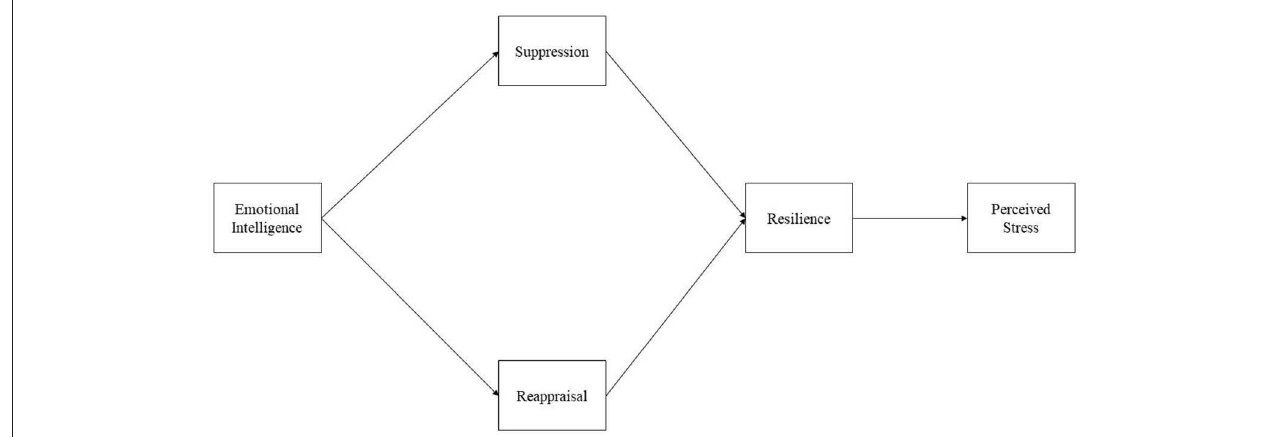
FIGURE 1 | Overview of the fully mediated a priori path